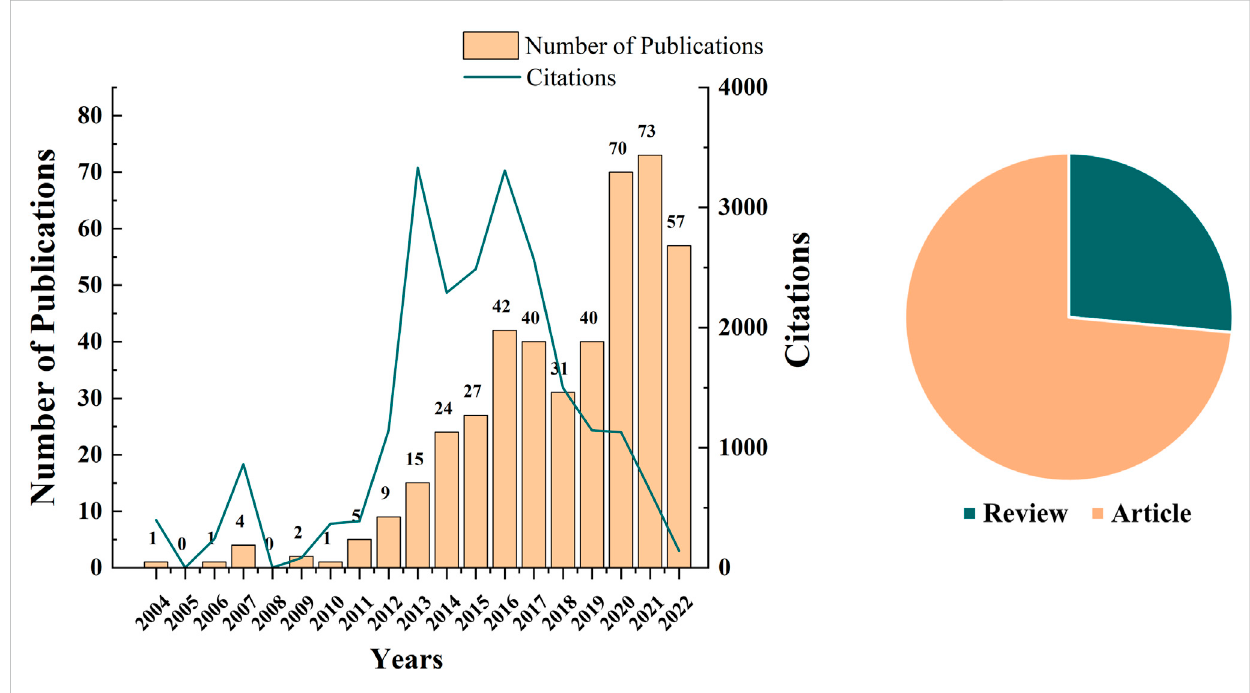
FIGURE 2 Annual publication volume and type of publications in UPR mt .